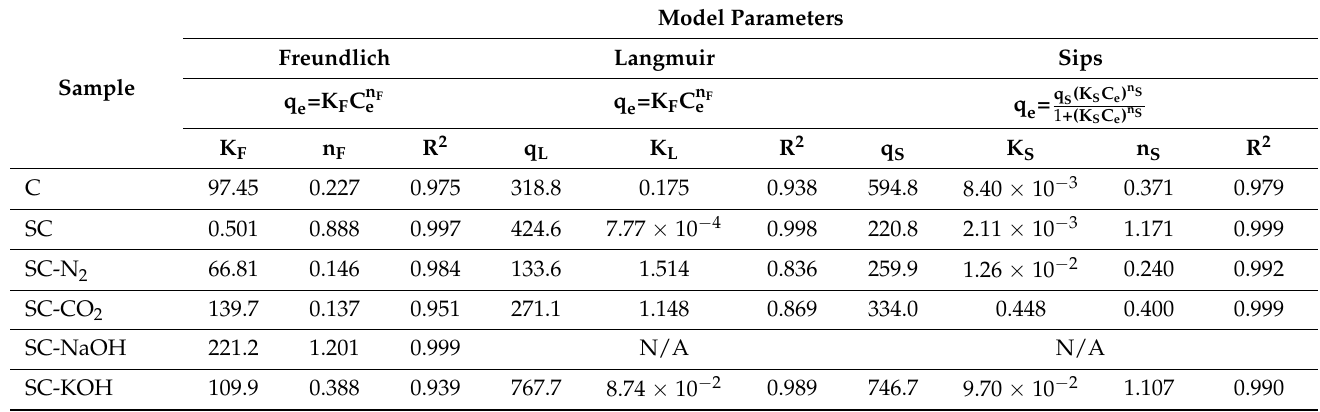
Table 4. Adsorption isotherm fittings after precipitation